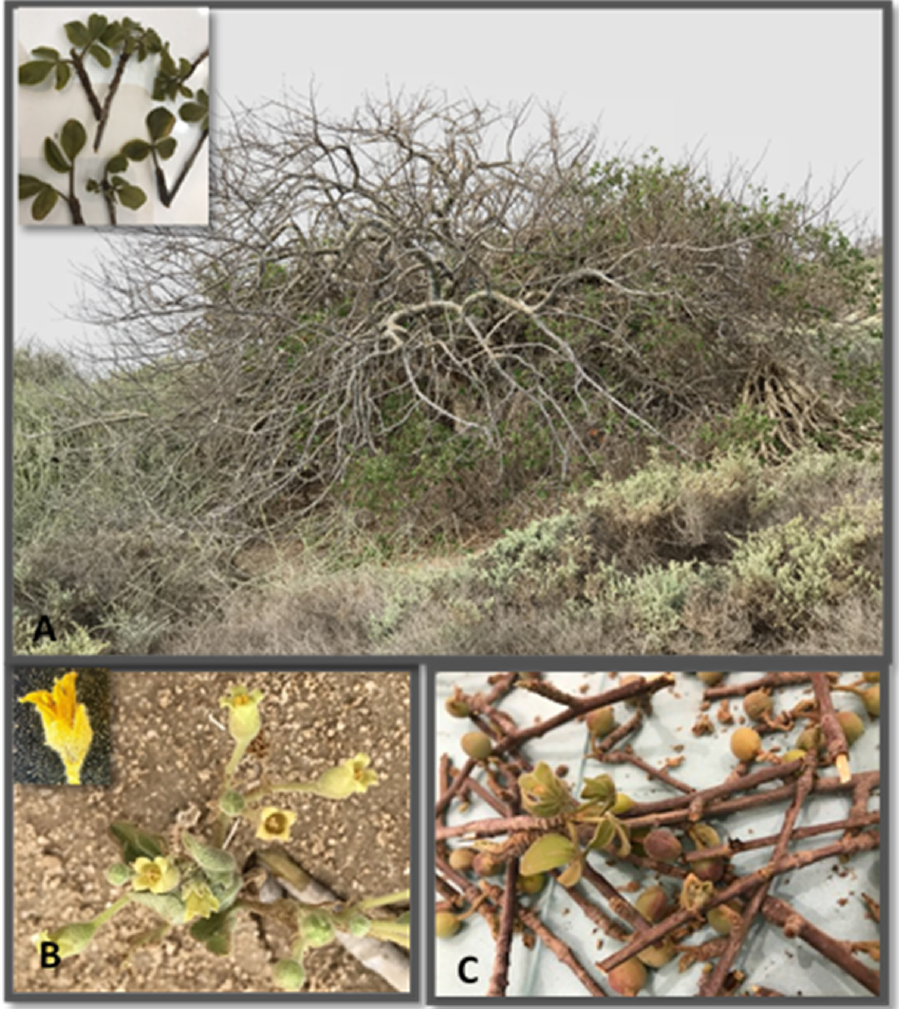
Figure 4. Commiphora erythraea ; ( A ): whole plant at naked stage, leaves at upper corner; ( B ): flowers upper view, and one flower is magnified at 1.2 × ; ( C ): fruits with dried twigs. Blade width was recorded at 4.5 ± (4–5) mm in C. myrrha and 7.5 ± (6–9) mm in C. erythraea and C. gileadensis , whereas it was 12 ± (10–14) mm in C. kataf and C. quadricincta . L/W ratio was calculated as less than 2 in C. erythraea , C. gileadensis , and C. kataf , but more than 2 in C. myrrha and C. quadricincta